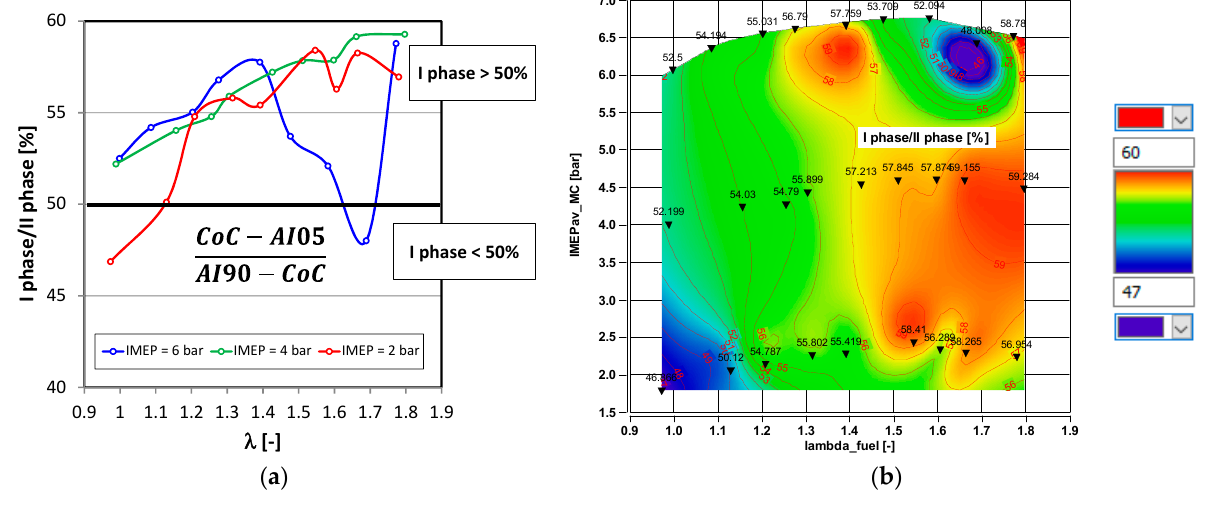
Figure 17. Analysis of the share of heat release time for the first and second combustion phases: ( a ) Percentage differences taking into account the load; ( b ) a map of percentage differences against changes in mixture composition and engine load.